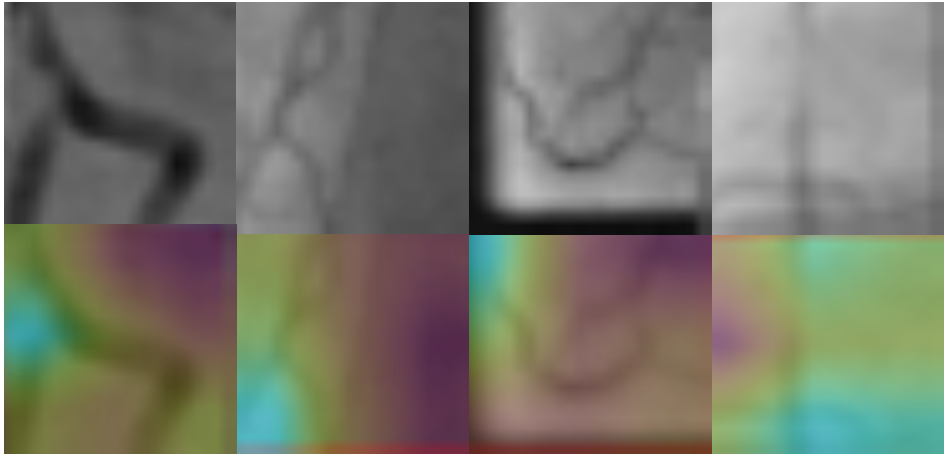
Figure 11. Raw XCA and Grad-class activation map (CAM) sample images of correctly and incorrectly predicted stenosis by the best-performing deep Convolutional Neural Network (CNN) model (pre-trained Inception-v3 fine-tuned with only real images). Left to right: true positive, true negative, false positive, and false negative. Below each raw sample images, a Grad-CAM image is blended over the original. Regions in light green or yellow indicate the region that has the most significant impact on